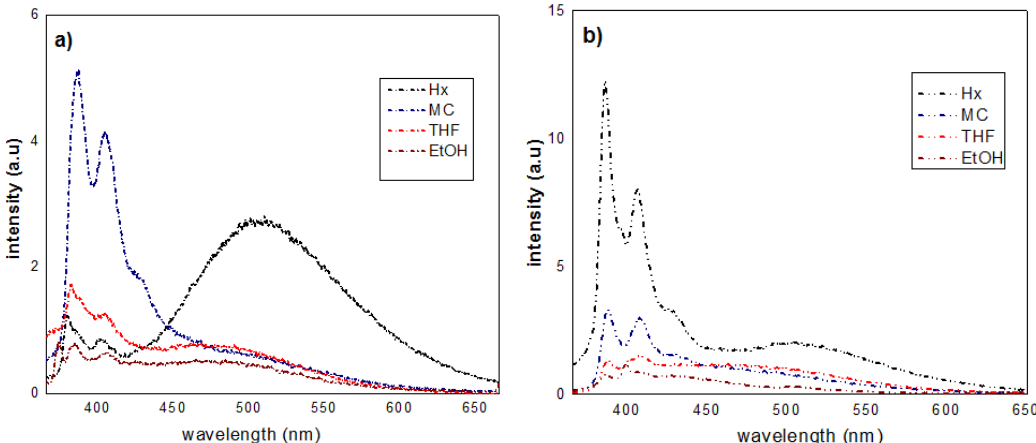
Figure 2. Emission spectra of solutions of ( a ) mTPEP and ( b ) pTPEP derivatives in solvent with different of polarities. Solution concentration: 10 µM. Excitation at their absorption maximum.